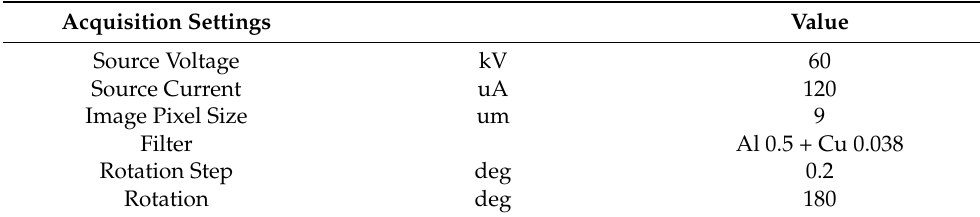
Table 2. Acquisition settings of the X-ray micro-tomography scans.